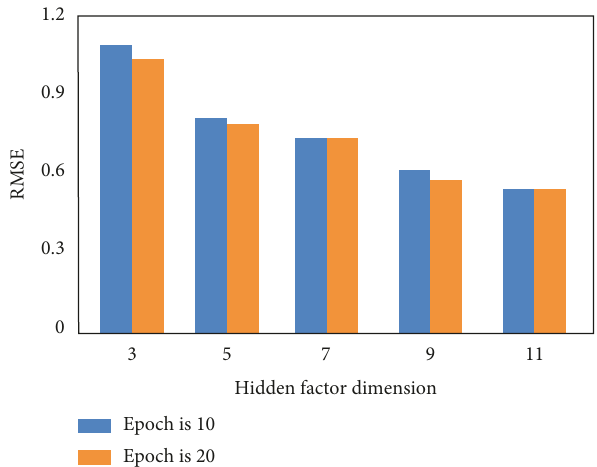
Figure 5: RMSE of predicted scores at different k and